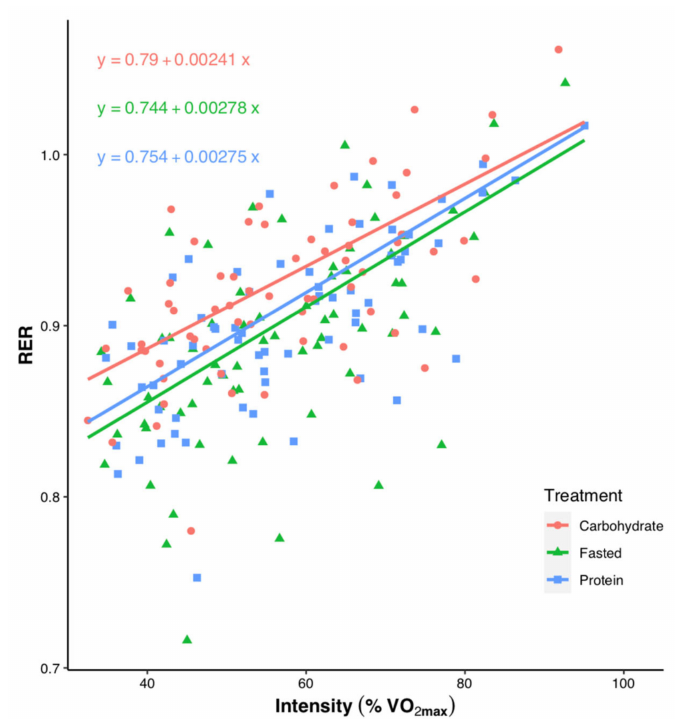
Figure 3. Individual data points showing correlations between each individual’s relative exercise intensity as a percentage of VO 2peak and respiratory exchange ratio (RER) during submaximal exercise, separated by treatment. Significant effects are found for treatment ( p < 0.001) and intensity ( p < 0.001). Trend line is based on model-estimated values.